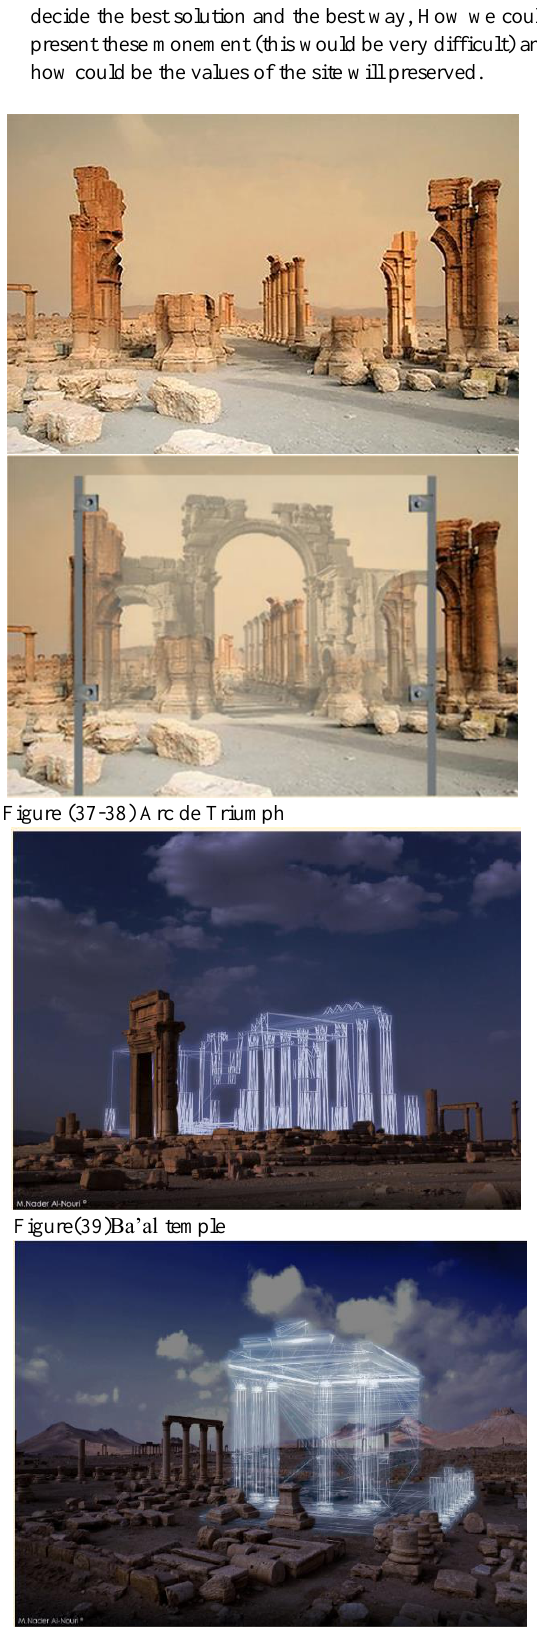
Figure (44-45) the cemeteries/wadi al-Qabour &